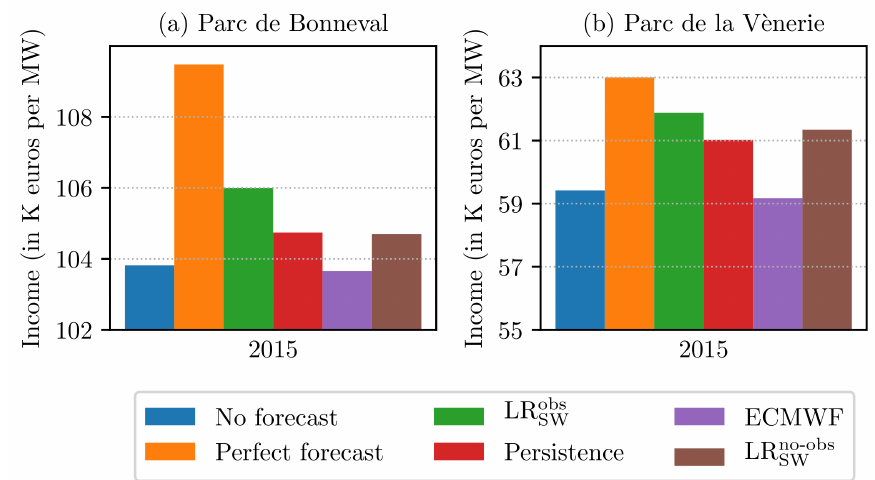
Figure 10. Aggregate income for 2015 for Parc de Bonneval ( a ) and Parc de la Vènerie ( b ). For both panels, we present the results for the case where no nowcast is available (blue bar), the case where the nowcast is perfect (orange bar), LR obs nowcasting model (dowscaling model with assimilation, SW green bar), persistence (red bar), ECMWF (violet bar), and LR no-obs model (downscaling model without SW assimilation, brown bar). The scale is different from one Figure to